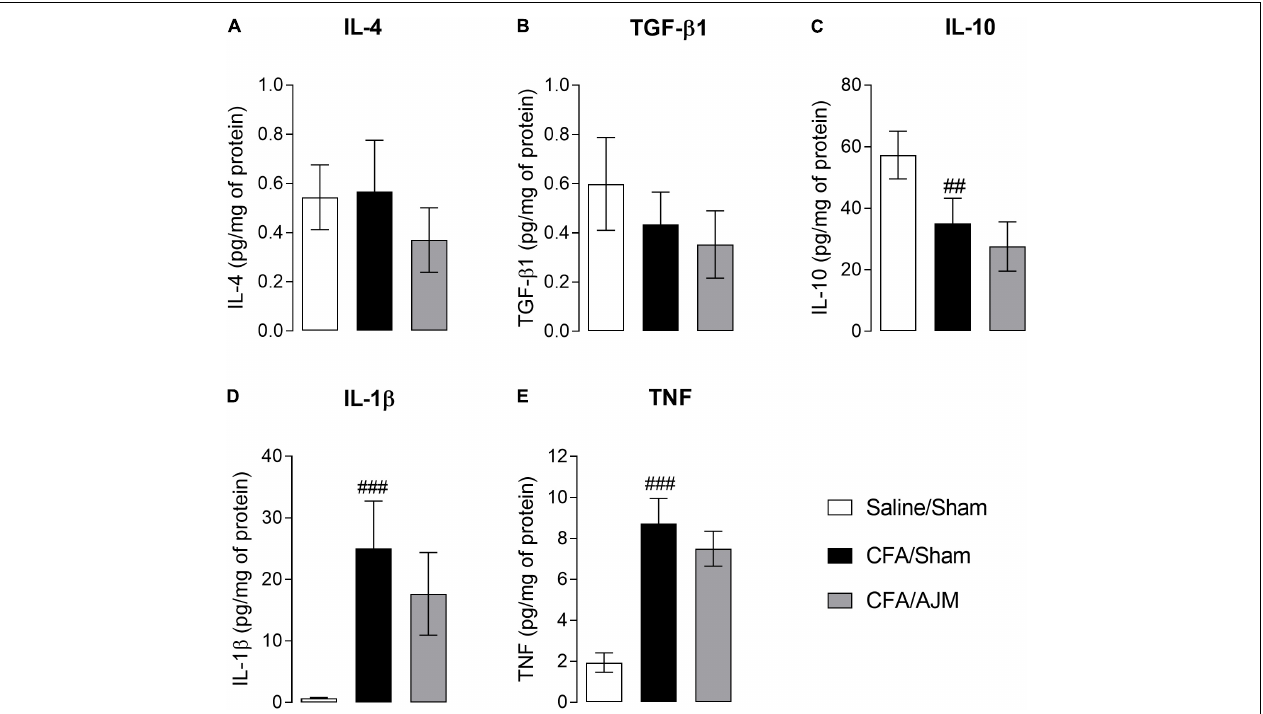
FIGURE 3 | Effects of AJM on the concentration of anti-inflammatory IL-4 (A) , TGF- β 1 (B) and IL-10 (C) , and pro-inflammatory IL-1 β (D) and TNF (E) cytokines on the paw of male Swiss mice 98 h after intraplantar CFA-induced inflammation. Data are expressed as mean ± SD of 7 animals per group, statistically assessed by one-way ANOVA followed by Tukey’s post hoc test. ## p < 0.01 and ### p < 0.001 when compared to the Saline/Sham group. CFA, Complete Freund’s Adjuvant; AJM, Ankle Joint